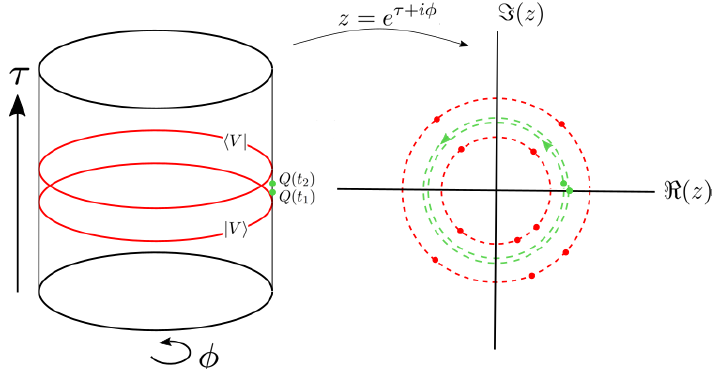
Figure 2. This diagram illustrates the e(cid:11)ect of the exponential map on states created on the Euclidean cylinder. The red dots correspond to the insertions of heavy operators while the green dots denote light probe